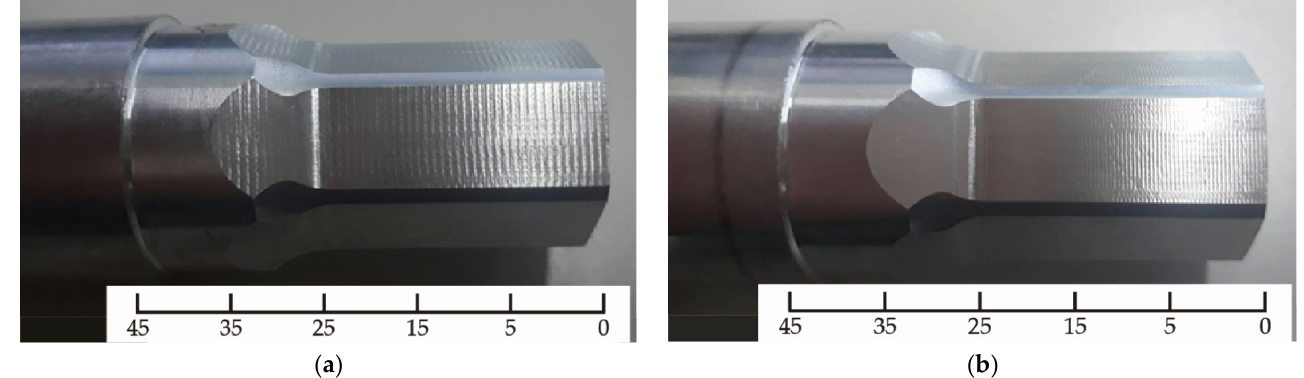
Figure 13. Shape of surface after ( a ) rough milling; and ( b ) finish milling.